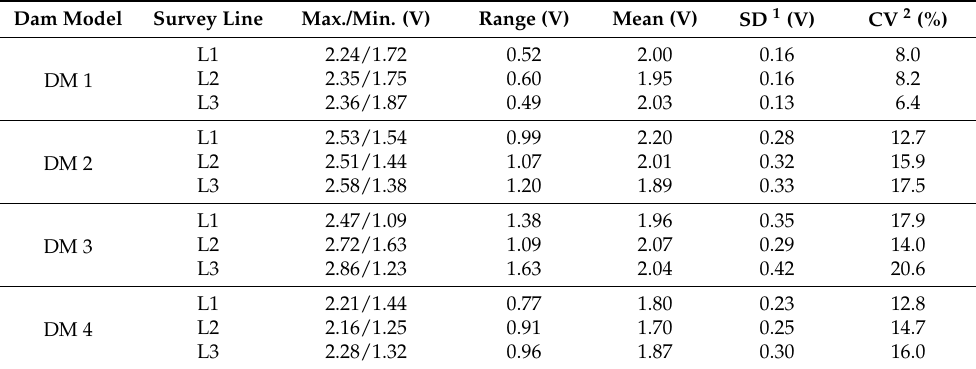
Table 6. Statistics of the